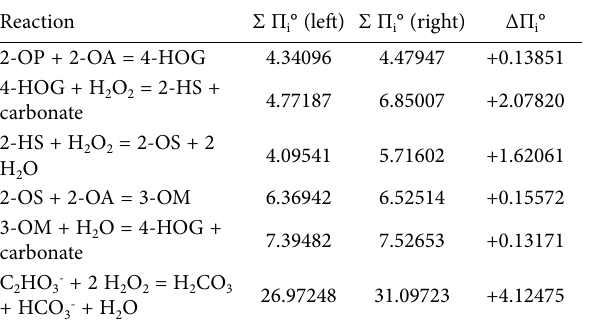
Table 6. Thermodynamic analysis of the 4-hydroxy-2-oxo-glutarate cycle represented at the bottom of figure 2. Such a cycle consume one glyoxylate molecule that is oxidized into carbon dioxide and water with an overall largely positive increase in entropy All values are given at pH = 7 and I = 0.25 M and reported in zJ·K -1 . Reaction